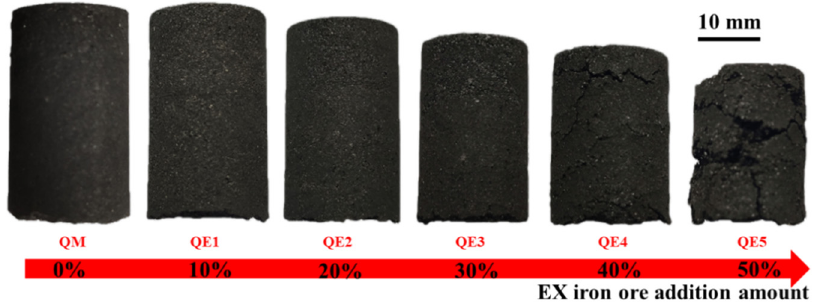
Figure 5. Macroscopic morphology of ferro-coke with different amounts of iron ore. Figure 6. Without iron ore, QM had the highest crushing strength, which was 92.25%. could maintain a higher crushing strength, which were 78.94% and 72.11%, respectively.